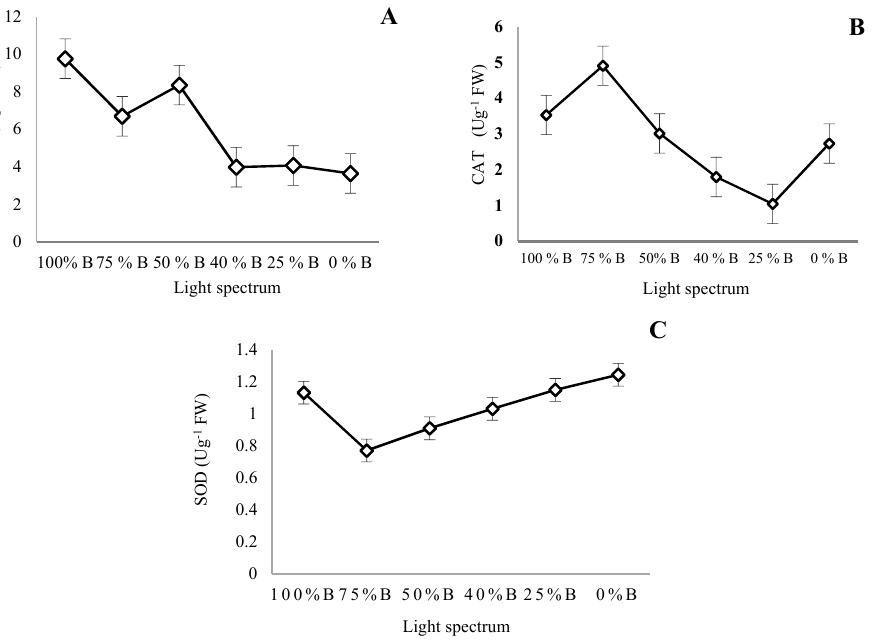
Figure 10. Ascorbate peroxidase ( A ; APX), catalase ( B ; CAT), and superoxide dismutase ( C ; SOD) activity of saffron plants grown under different ratios of Blue (B) to Red (R) light in the overall spectral composition, including 100% B, 75% B, 50% B, 40% B, 25% B, 0% B (see the spectrum in Figure 1), with 150 ± 10 μ mol m − 2 s − 1 PPFD. Bars represent mean value ± standard deviation ( p ≤ 0.01).